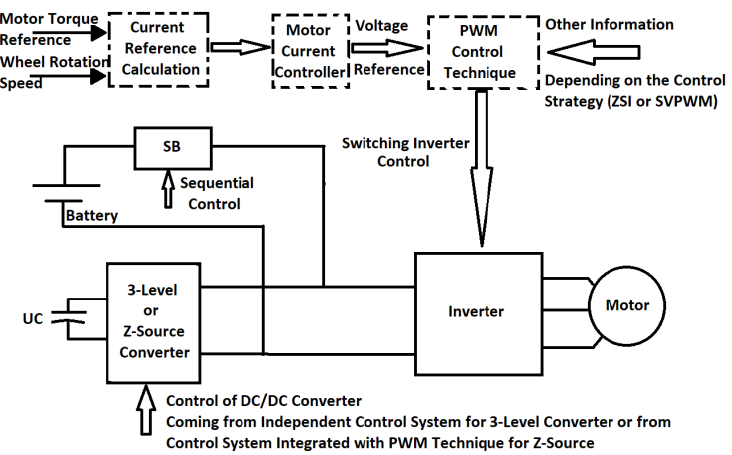
Figure 14. Models at HESS level.